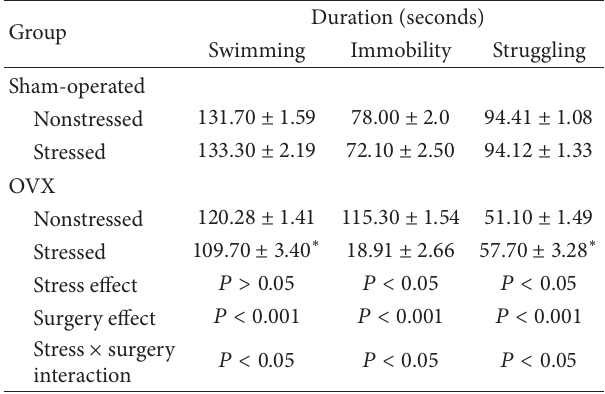
Table 1: Effects of surgery and stress on depressive-like behaviour.